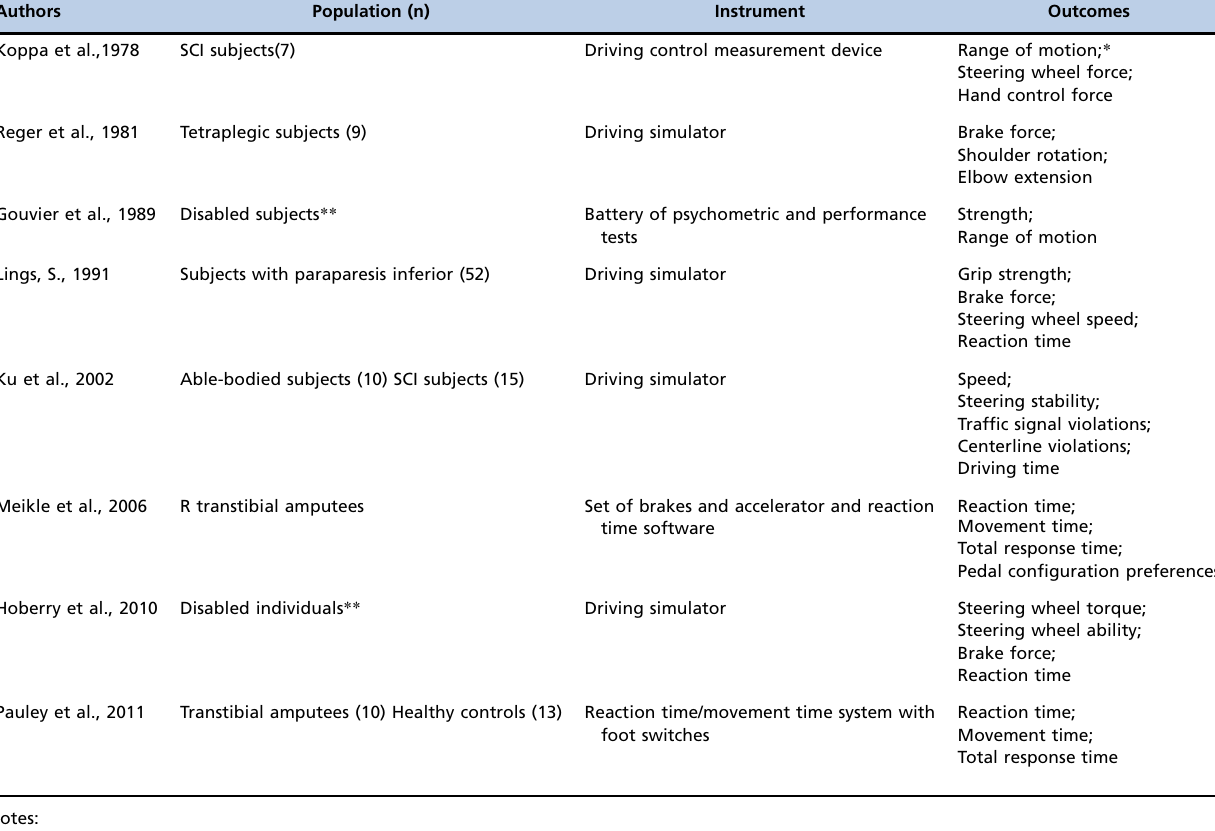
Table 2 - Primary outcomes and tools used in the selected studies of driving assessments for lower extremity-impaired